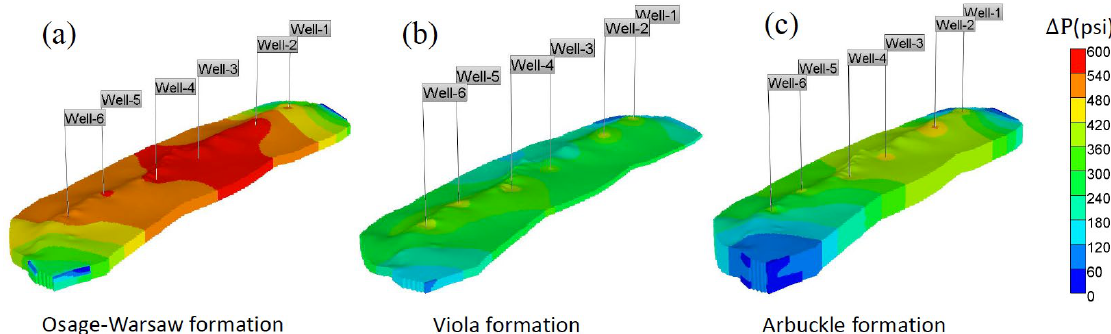
Figure 12. Static geological models with simulation results of the Patterson Field after 25 years of injection using porosity and permeability values interpreted from well logs and core analysis data.